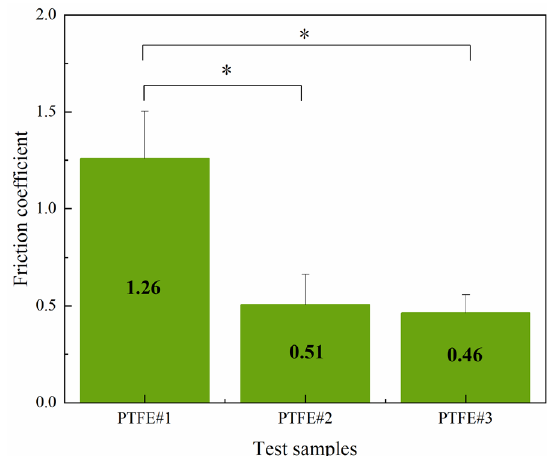
Figure 4 Friction coefficient measured for three PTFE samples. Each test was performed three times, the error bars indicate the standard deviation. The “*” indicates a significant difference (p < 0.05) between two results